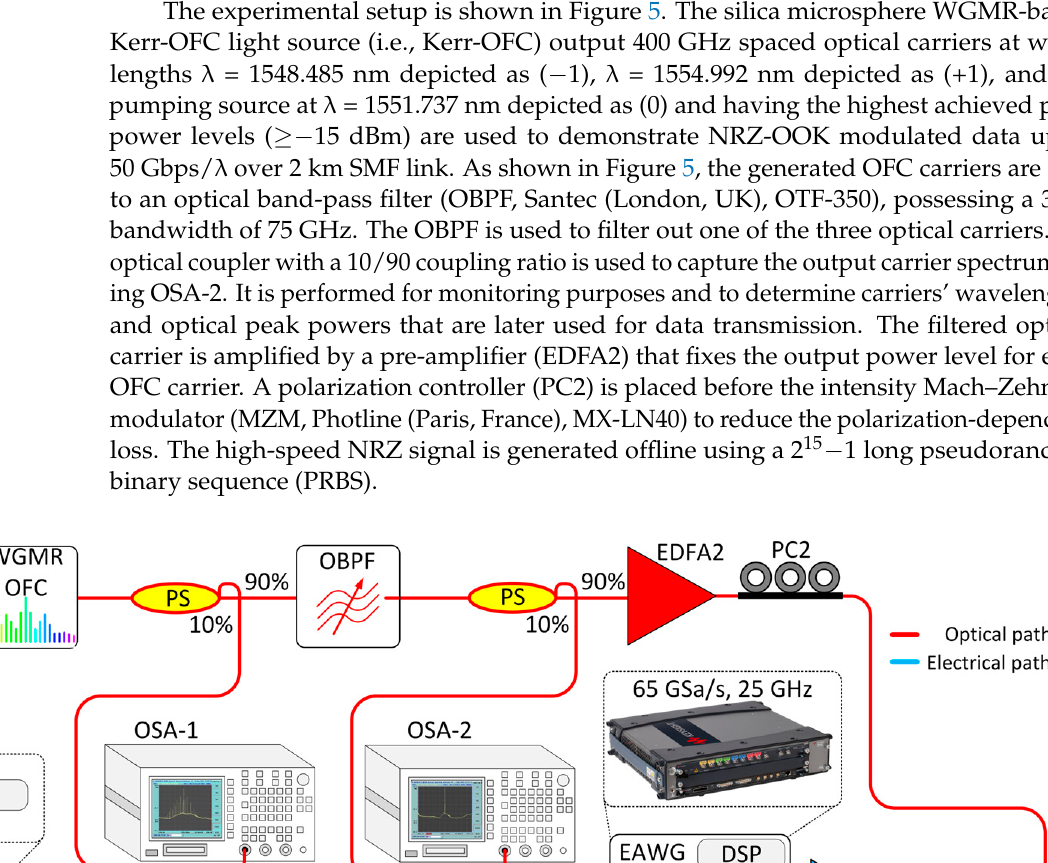
Figure 6. End-to-end system calibration using the EAWG for the OB2B configuration: ( a ) phase re- sponse and ( b ) amplitude response. The high-speed NRZ encoded signal is loaded to the EAWG, pre-equalized, and transmitted. The generated output electrical signals are amplified by an electrical ampli- fier (EA-1, 38 GHz, and 29 dB gain) and fed into the S 1 (t) input of the MZM with a null